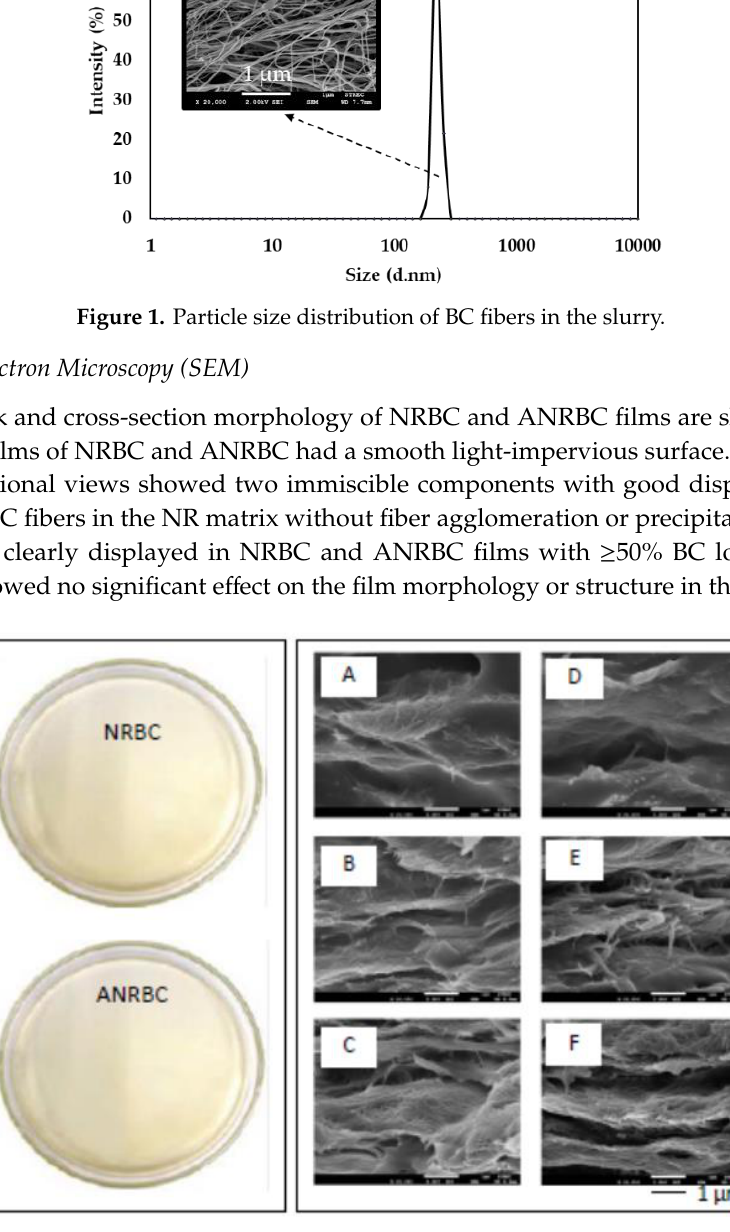
Figure 2. The outlook (left) and SEM images of cross section views (right) of NRBC20 ( A ), NRBC50 ( B ), NRBC80 ( C ), ANRBC20 ( D ), ANRBC50 ( E ), and ANRBC80 ( F ).